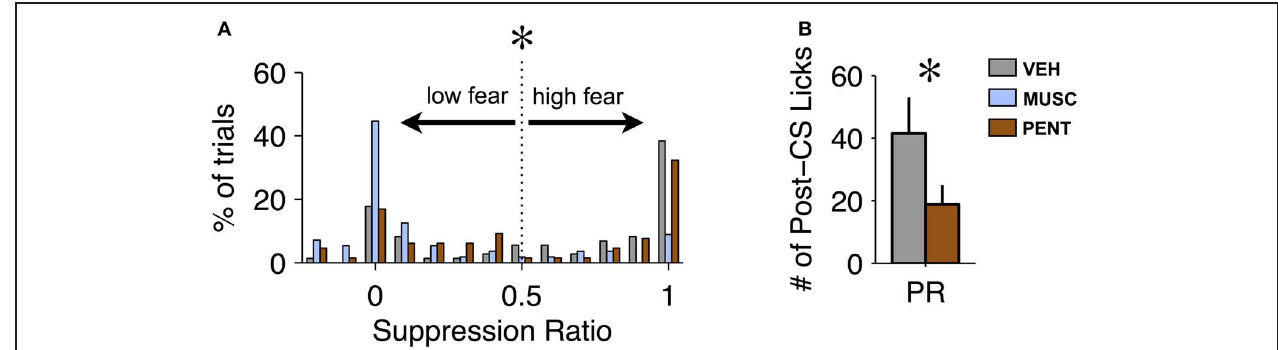
trials: trials where the suppression ratio was greater than 0.5. (B) Mean ± SE number of licks during the 20s post-CS interval from vehicle and pentagastrin sessions after CS-alone trials where the suppression ratio was greater than 0.5. Post-CS licking after “high fear” trials, a proxy to recovery from fear, was significantly lower in pentagastrin sessions than vehicle sessions [ANOVA, F ( 1 , 6 ) = 8 . 05, p = 0 . 006].